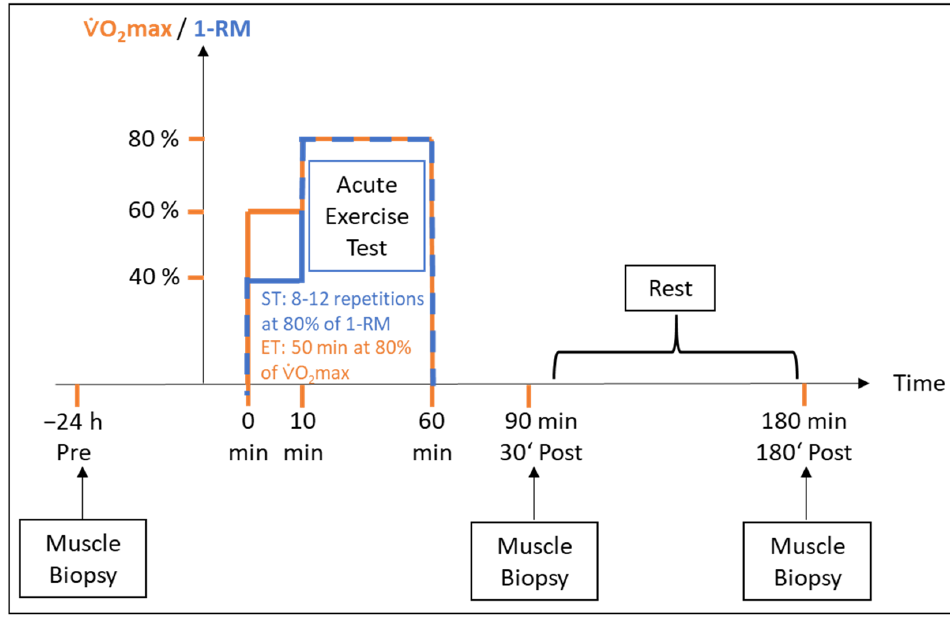
Figure 4. Schematic illustrating the acute exercise testing procedures. Prior to the exercise test, a skeletal muscle biopsy was taken at rest. For the acute endurance exercise test, participants cycled for 50 min at 80% of ⩒ O 2 max. The strength test consisted of 8–12 repetitions at 80% of 1-RM (bench pull, knee extension, bench press, leg press). Skeletal muscle biopsies were taken prior to exercise (Pre), 30 min (30 ′ Post) and 180 ′ post-exercise (180 ′